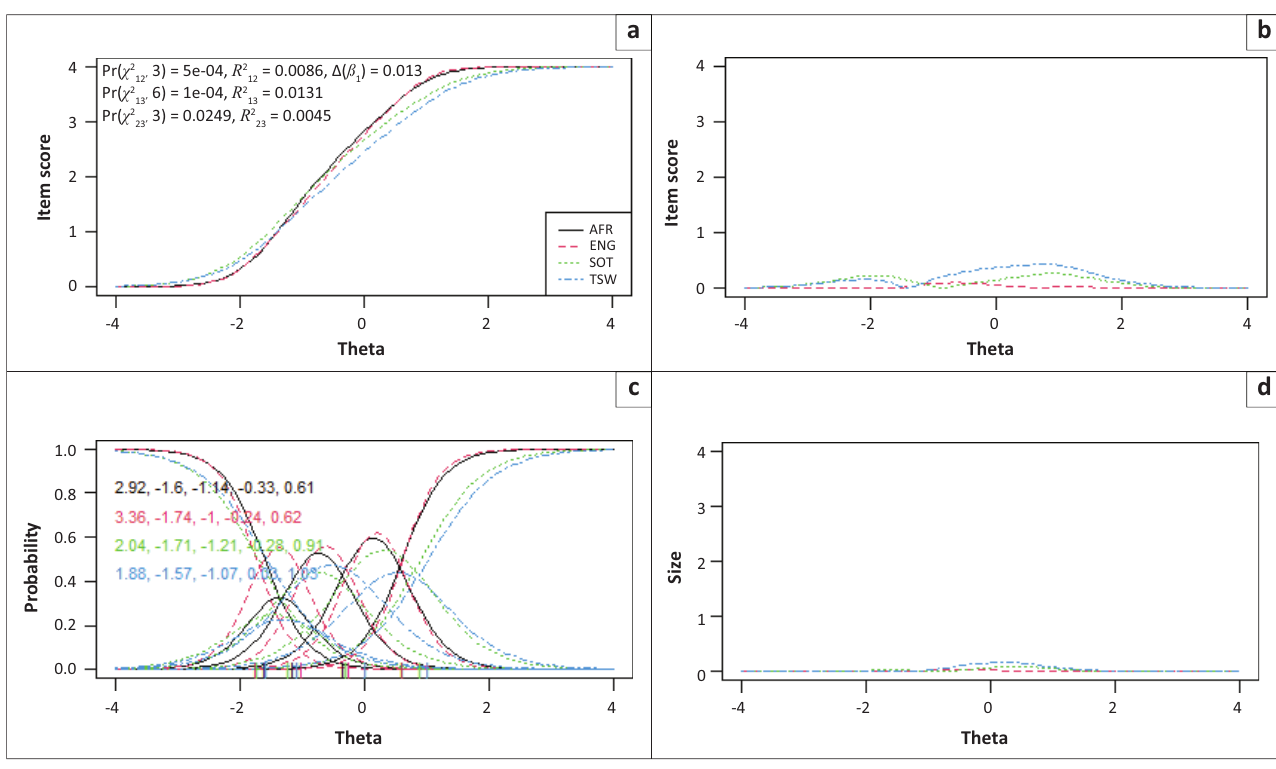
FIGURE 1: Graphical display of Item 2, which shows uniform and non-uniform differential item functioning with respect to language groups. (a) Items True Score Functions - item 2; (b) differences in items True Score Functions; (c) Item Response Functions; (d) Impact (weighed by density).